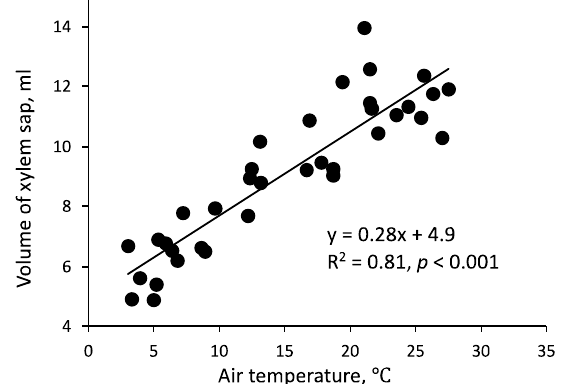
Figure 3. Relationship between the monthly volume of xylem sap collected in Q. serrata and the mean monthly air temperature. The presented data were from Experiments 1–3.